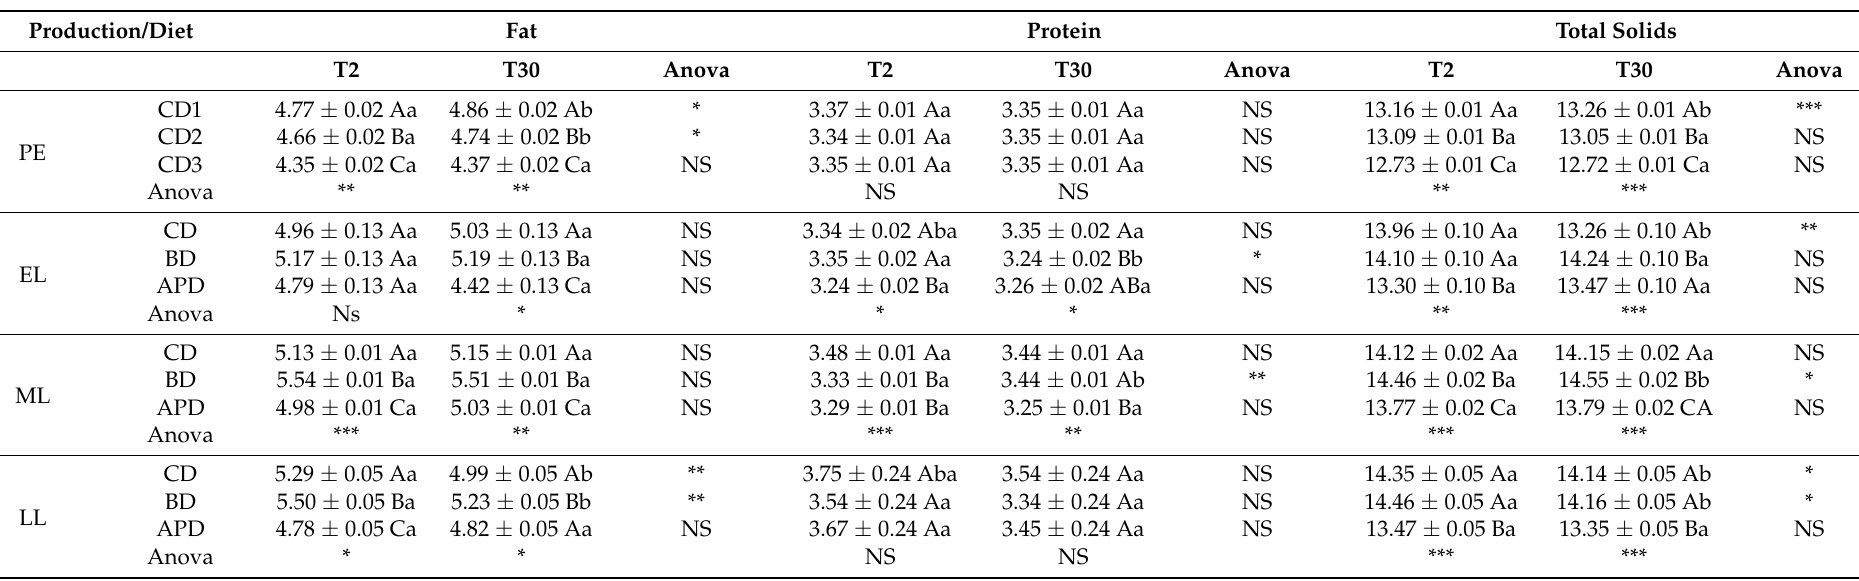
Table 2. Main components (fat, protein and total solids) content (g/100 g) in fermented milk manufactured and stored for 2 and 30 days with milk from Murciana-Granadinas goats fed differentiated diets, using a thermophilic (YO-MIX TM 300) starter culture.